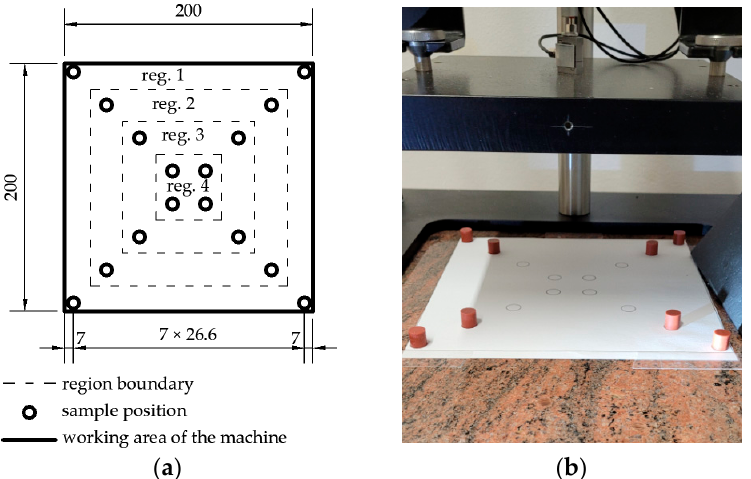
Figure 2. Arrangement of samples during the test: ( a ) plan of the arrangement of samples on the machine plate with regions in which samples were placed sequentially (dimensions in millimetres); ( b ) photo of the sample testing r = 5 mm, h = 10 mm, 8 pcs (loaded regions 1 and 2).